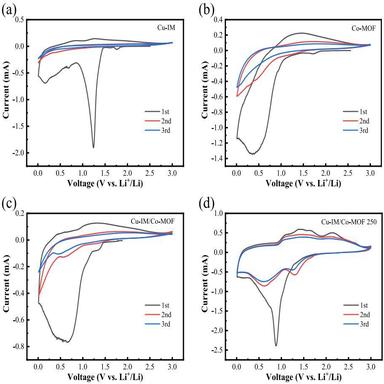
CV curves for the first three cycles at a scan rate of 0.2 mV s − 1 of (a) Cu-IM, (b) Co-MOF, (c) Cu-IM/Co-MOF, (d) Cu-IM/Co-MOF 250.